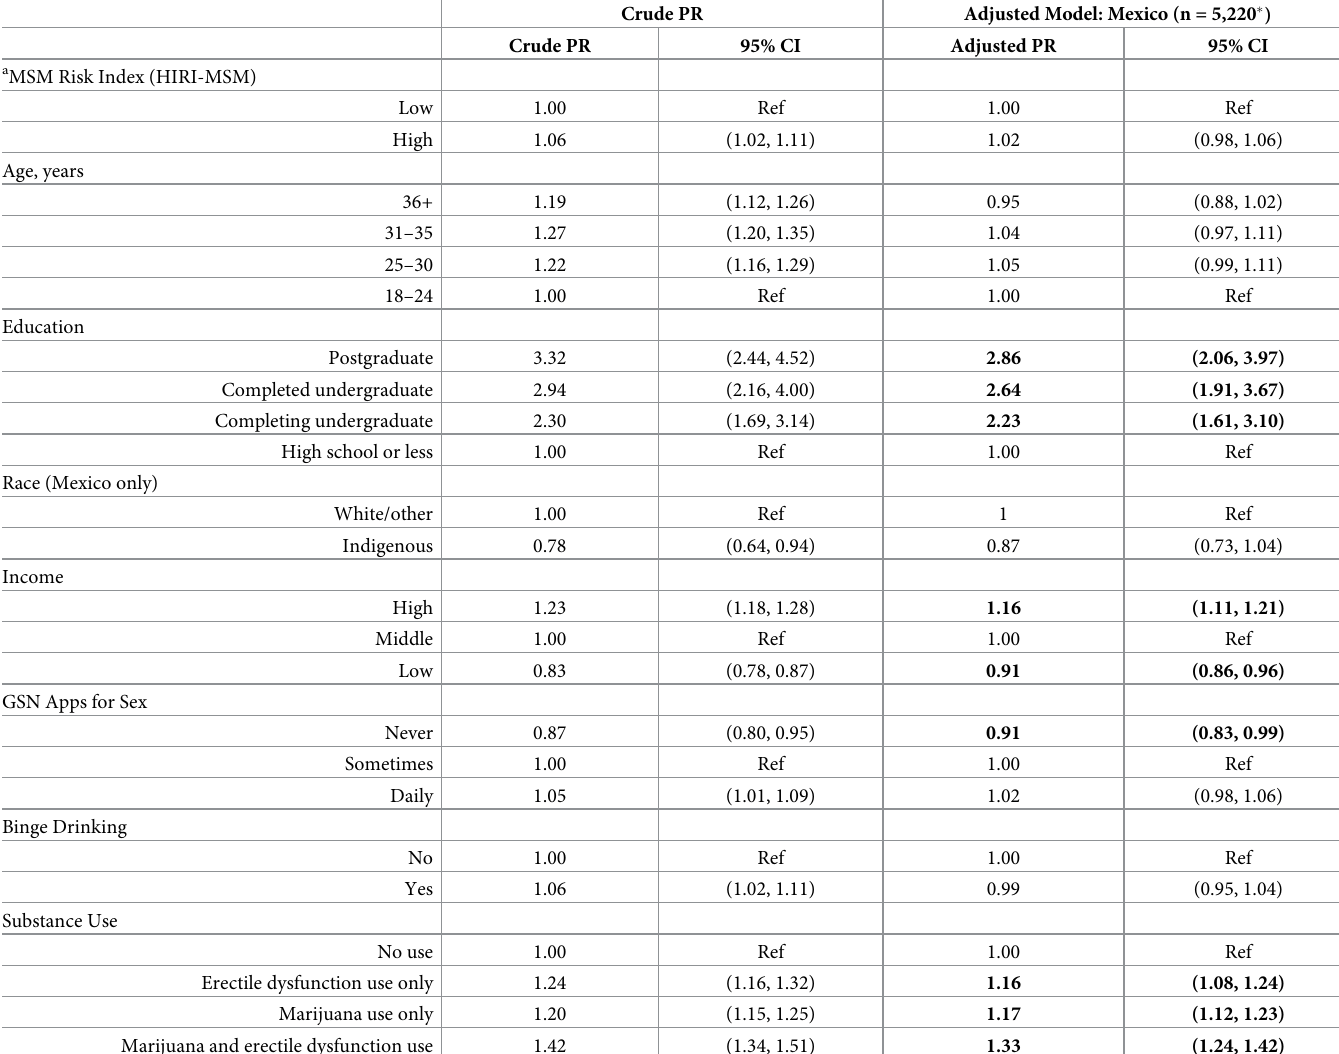
Table 3. PrEP awareness among MSM in Mexico, crude and adjusted prevalence ratios (n = 5,921) April,